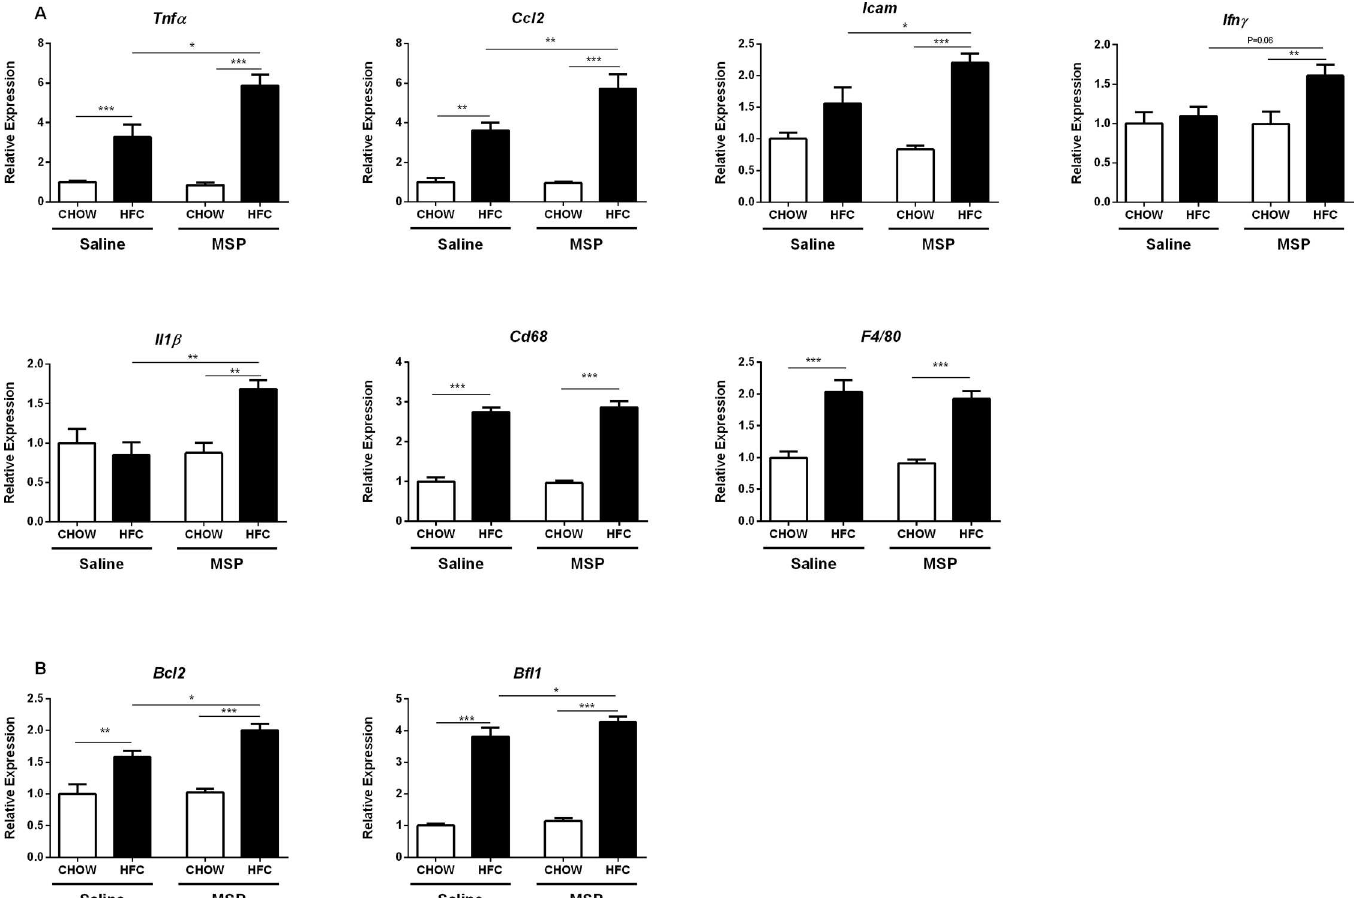
Fig 4. Hepatic expression levels of genes related to inflammation. (A) Gene expression levels of the pro-inflammatory cytokines, tumor necrosis factor alpha ( Tnf α ), chemokine (C-C motif) ligand 2 ( Ccl2 ), intercellular adhesion molecule1 ( Icam1 ), interferon gamma ( Ifn γ ), interleukin1 beta ( Il1 β ), macrophage markers F4/80 and Cluster of differentiation 68 ( Cd68 ) in the livers of Ldlr -/- mice on chow or HFC diet, with or without MSP treatment. (B) Hepatic gene expressionlevels of B-cell lymphoma 2 ( Bcl2 ) and BCL2-related protein A1 ( Bfl1 ). Data are represented as mean ± SEM. * , ** and *** indicate significant differences between groups, with * p (cid:20) 0.05, ** p < 0.01, *** p <